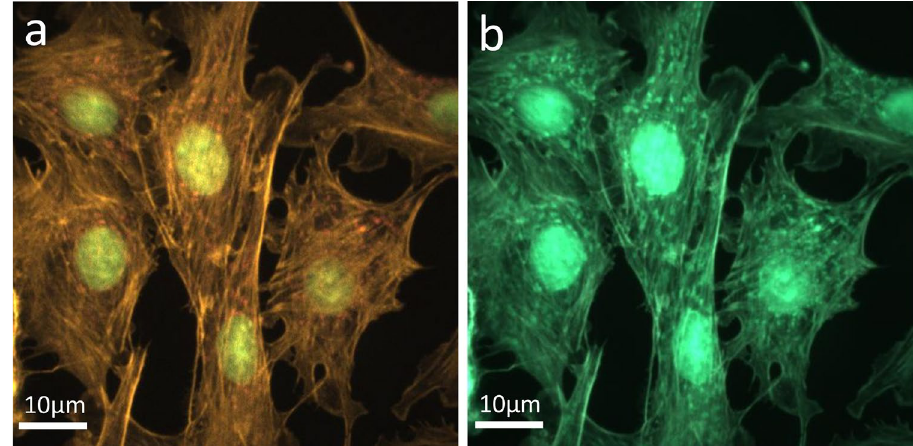
Figure 6. Synthesized fluorescence images using conventional FTS without He-Ne correction for various sampling numbers (N): ( a ) N = 1000, and ( b ) N = 50. Scale bars: 10 μm.